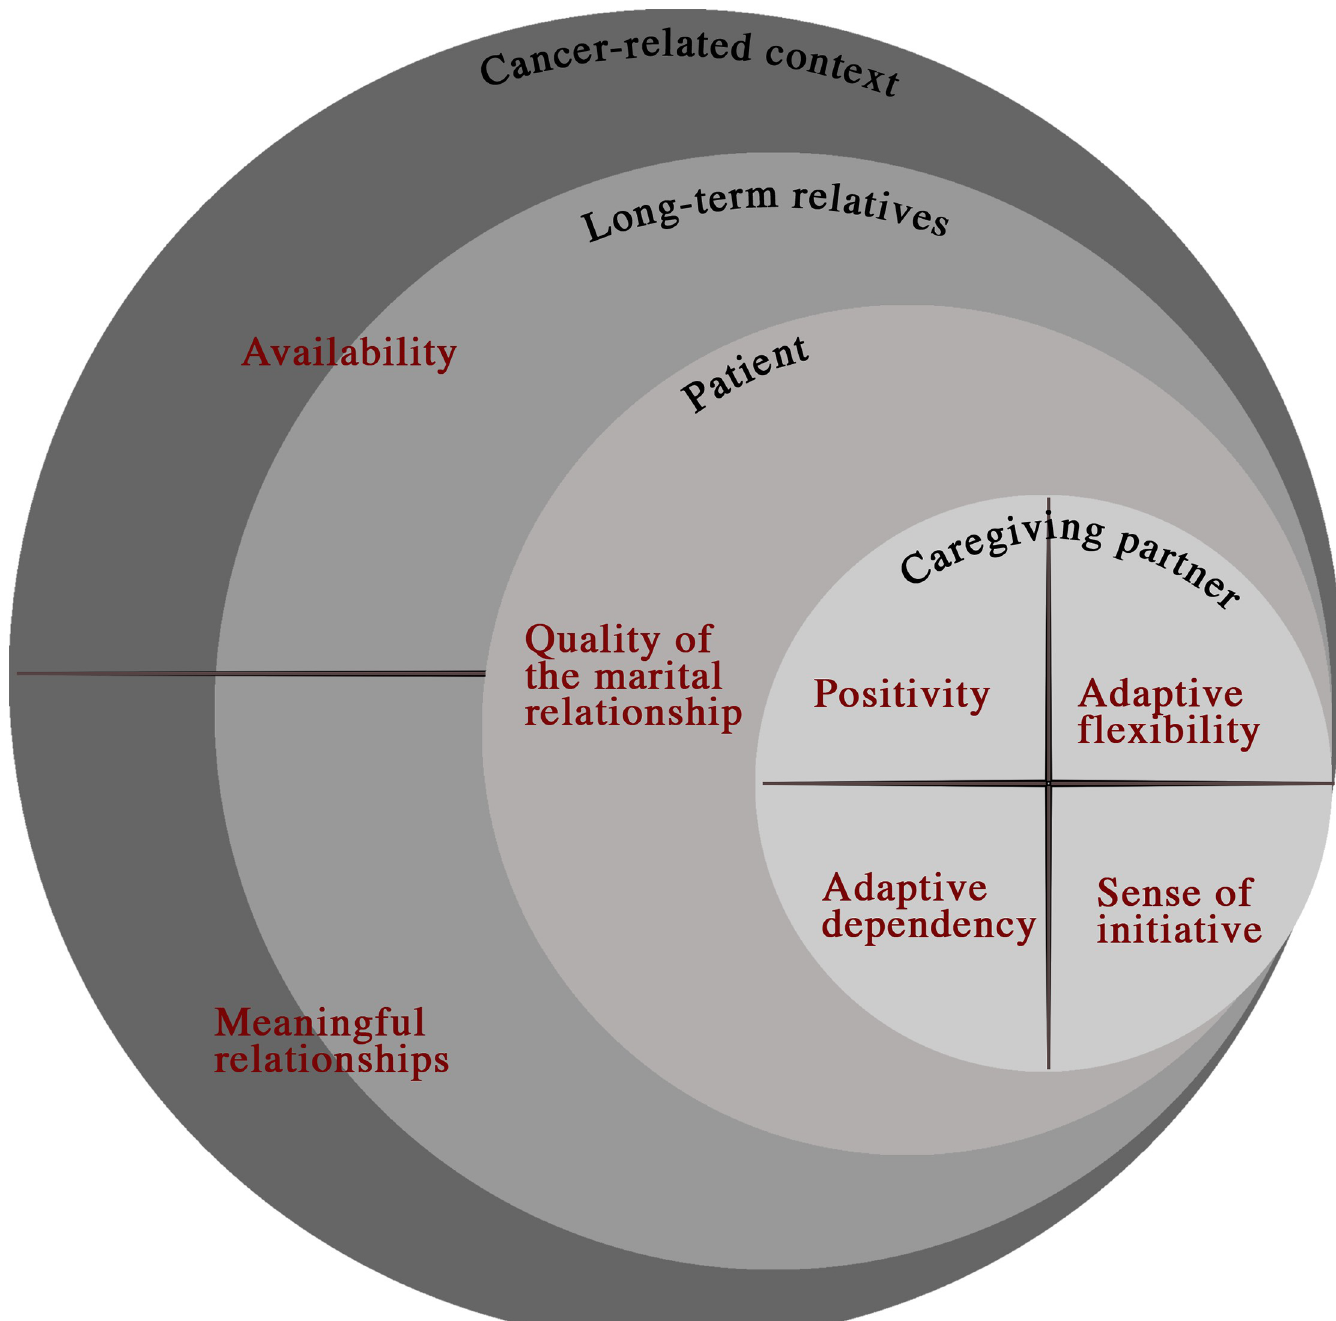
Fig 1. Intrinsic and extrinsic resilience facilitators in middle-aged partners of patients diagnosed with incurable cancer.